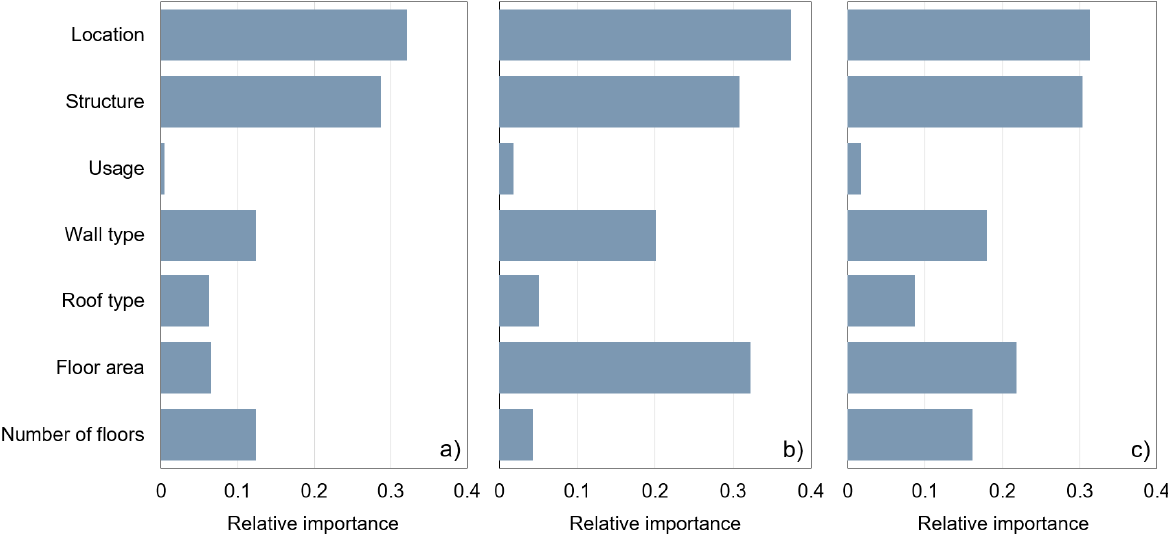
Figure 7. Relative importance of input variables by ( a ) ANN − ReLu, ( b ) SVM − Polynomial, and ( c ) ANN − Logistic models.